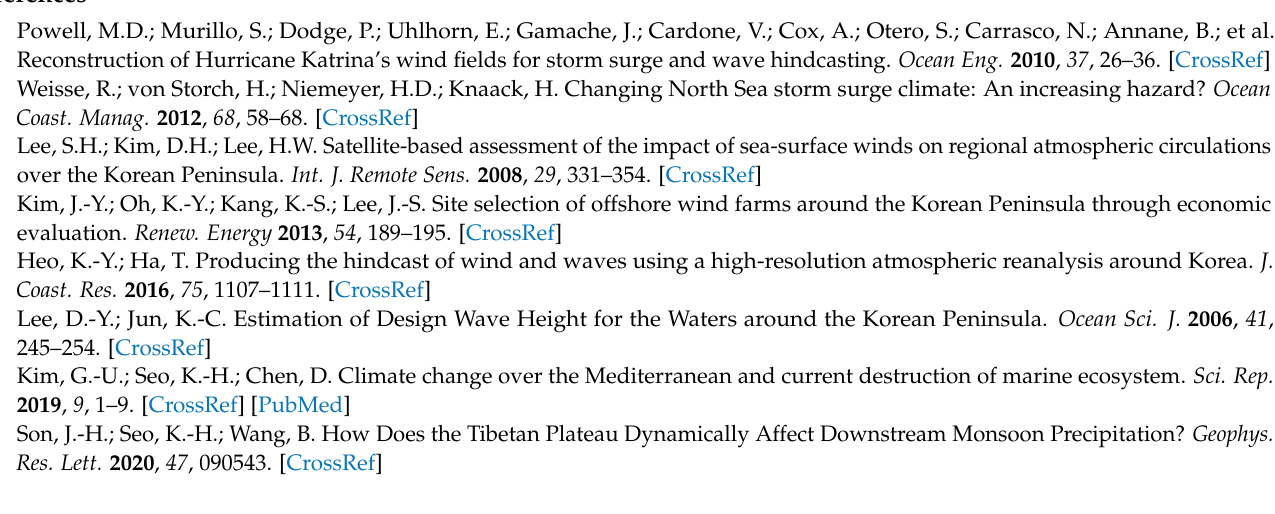
test, Figure S1: Taylor diagram for the wind speed over study area from 8 sensitivity test simula- tions for ERA-Interim and NCEP FNL, Figure S2: Time series of model wind speed at each buoy station, Figure S3: Scatter plots of hourly wind speed between buoy observations and model wind speed, Table S2: Error metrics for the hourly wind speed derived from buoy observations and each sensitivity